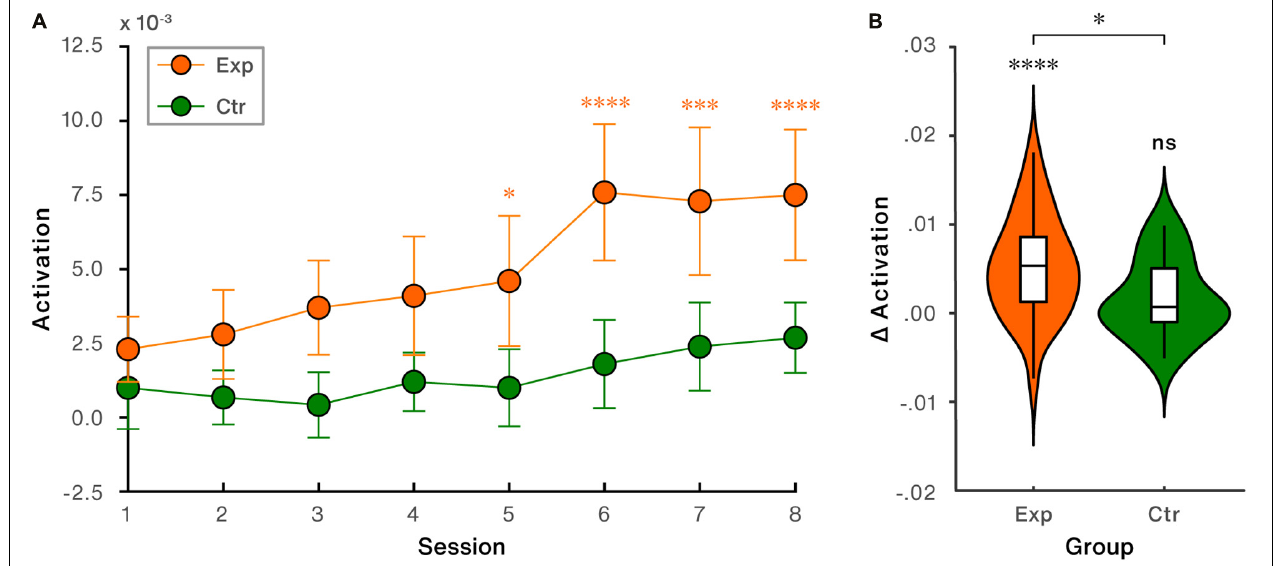
FIGURE 5 | NFB-induced activation performance in the target region (channel 8: lateral parietal cortex). (A) Trends of NFB-induced activation across all sessions. Error bars indicate standard error of the mean (SEM). (B) NFB-induced activation changes (last session vs. first session). ∗ p < 0.05; ∗∗∗ p < 0.001; ∗∗∗∗ p < 0.0001; ns,